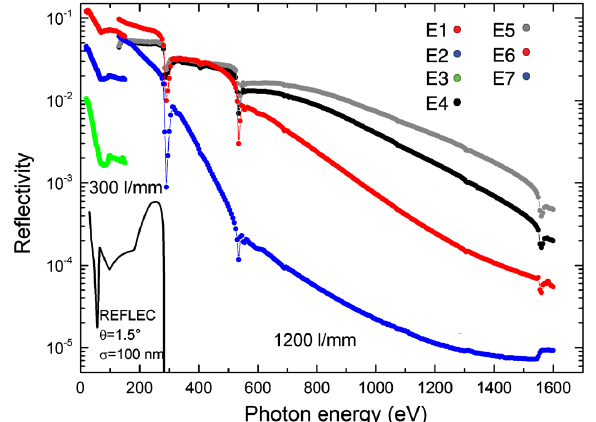
FIG. 18. Observed reflectivity, as a function of energy, alumi- num sample #1, for cases listed in Table IV, and simulation of specular reflectivity for a σ ¼ 100 nm roughness mirror using the REFLEC